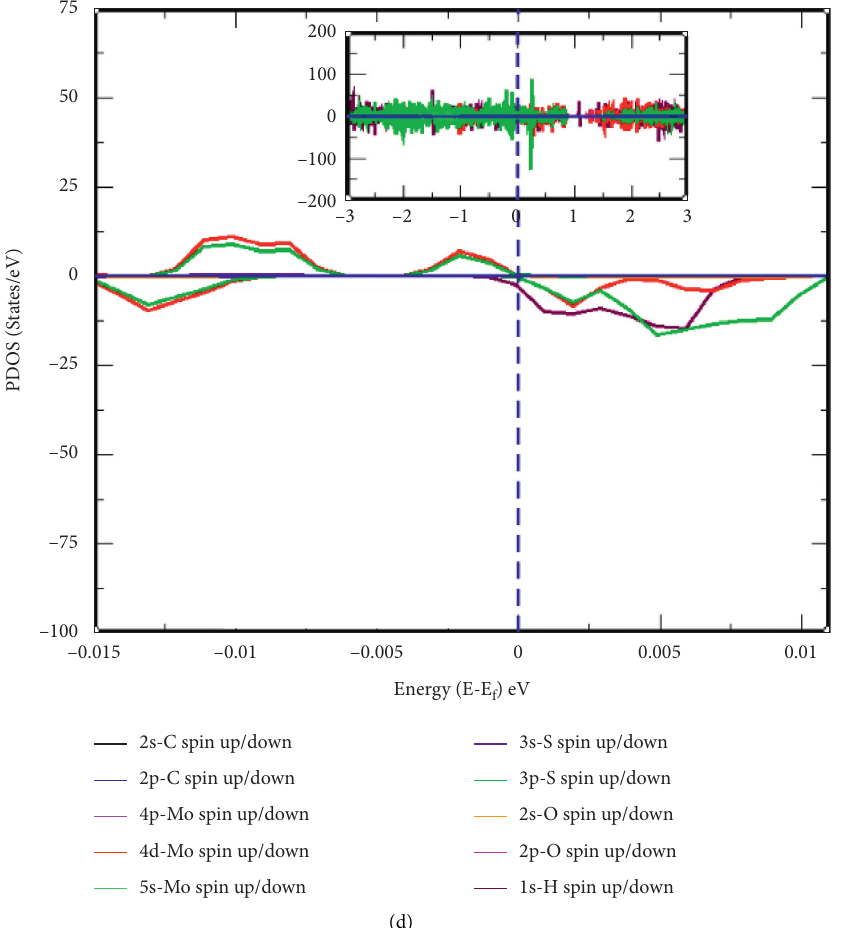
Figure 6: (a) Band structure of system-IIc, (b) DOS of up-spin and down-spin states of electrons in the orbitals of C Mo, S O, and H atoms of system-IIc, (c) PDOS of total up-spin and total down-spin states of electrons in the orbitals of C Mo, S O, and H atoms of system-IIc, and (d) PDOS of individual up-spin and down-spin states of electrons in the orbitals of C Mo, S O, and H atoms of system-IIc. In all DOS and PDOS, the horizontal dot line separates the spin states and the vertical dot line separates the electronic bands, and also in the band plot, the horizontal dot line represents the Fermi energy level. Insets in DOS and PDOS represent the spin states within a large energy range along x -axis.